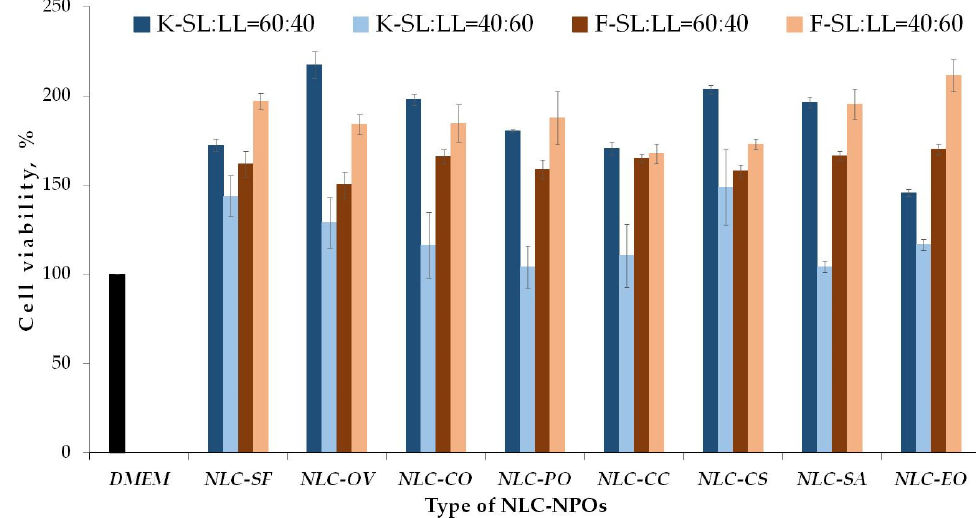
Figure 8. Proliferation (% viability) of HaCaT and HDFn in the presence of NLC-NPOs. K—keratinocytes (HaCaT), F– fibroblasts (HDFn); Dilution factor is 1/100. Medium (DMEM) was used as comparison (positive control) (mean value ± SD; n = 3).